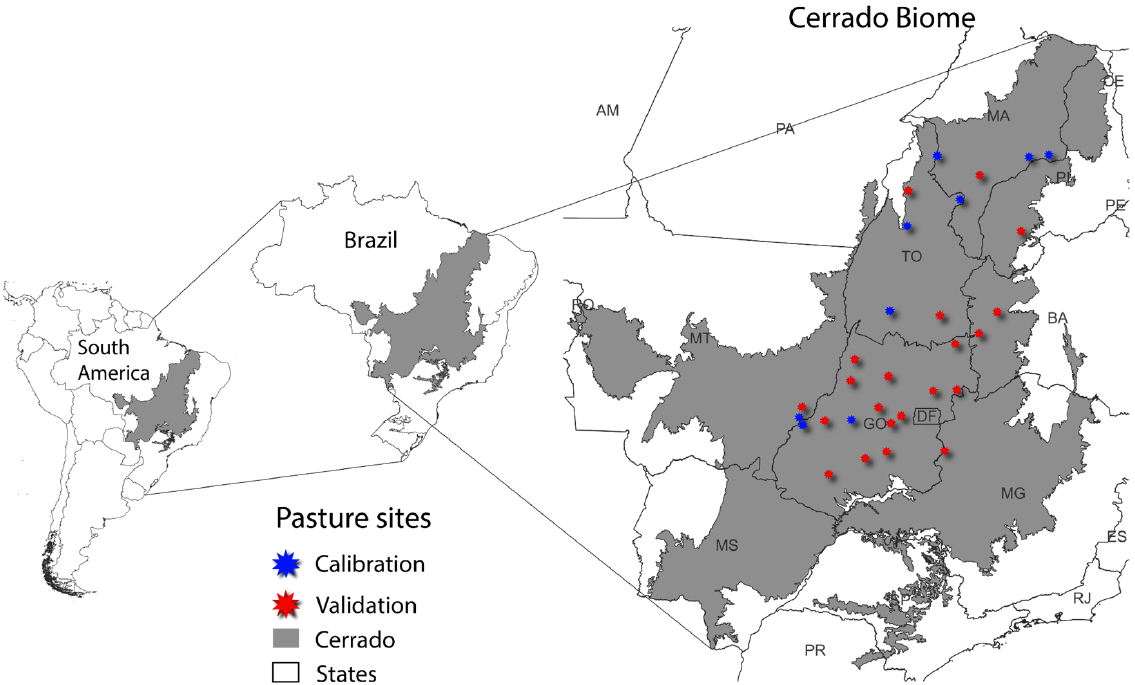
Figure 1. Map of the study area (Cerrado biome), with the location of the calibration and validation sites used to simulate carbon dynamics in the pastures of the Cerrado biome based on the CENTURY model.